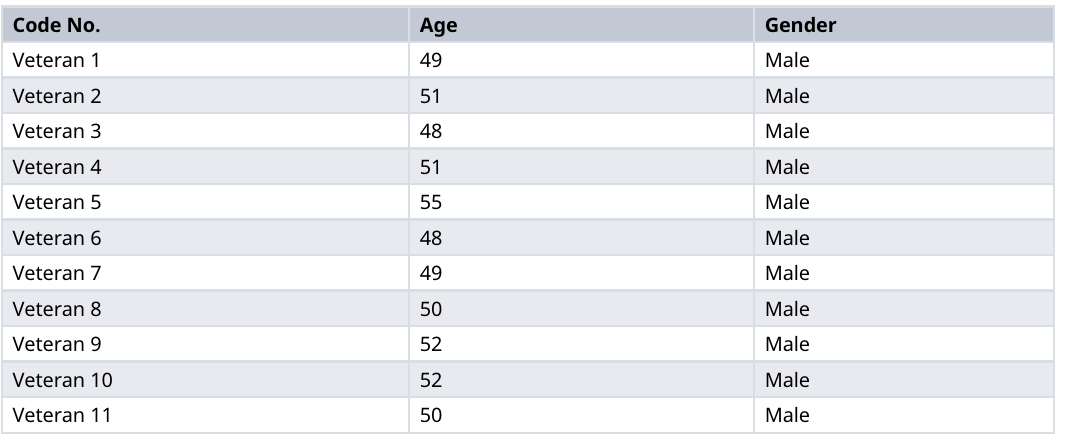
Table 1. Demographic data of the